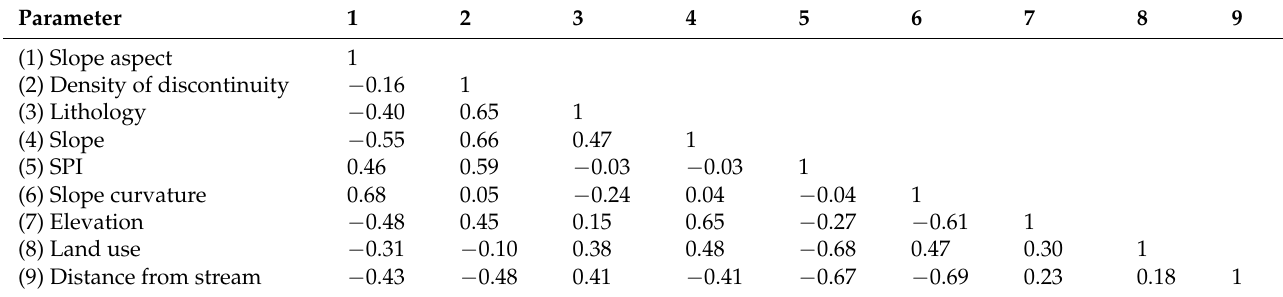
Table 8. Pearson’s correlation of coefficient